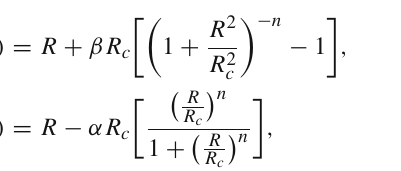
km , respectively. 0 . 5 s . Mpc